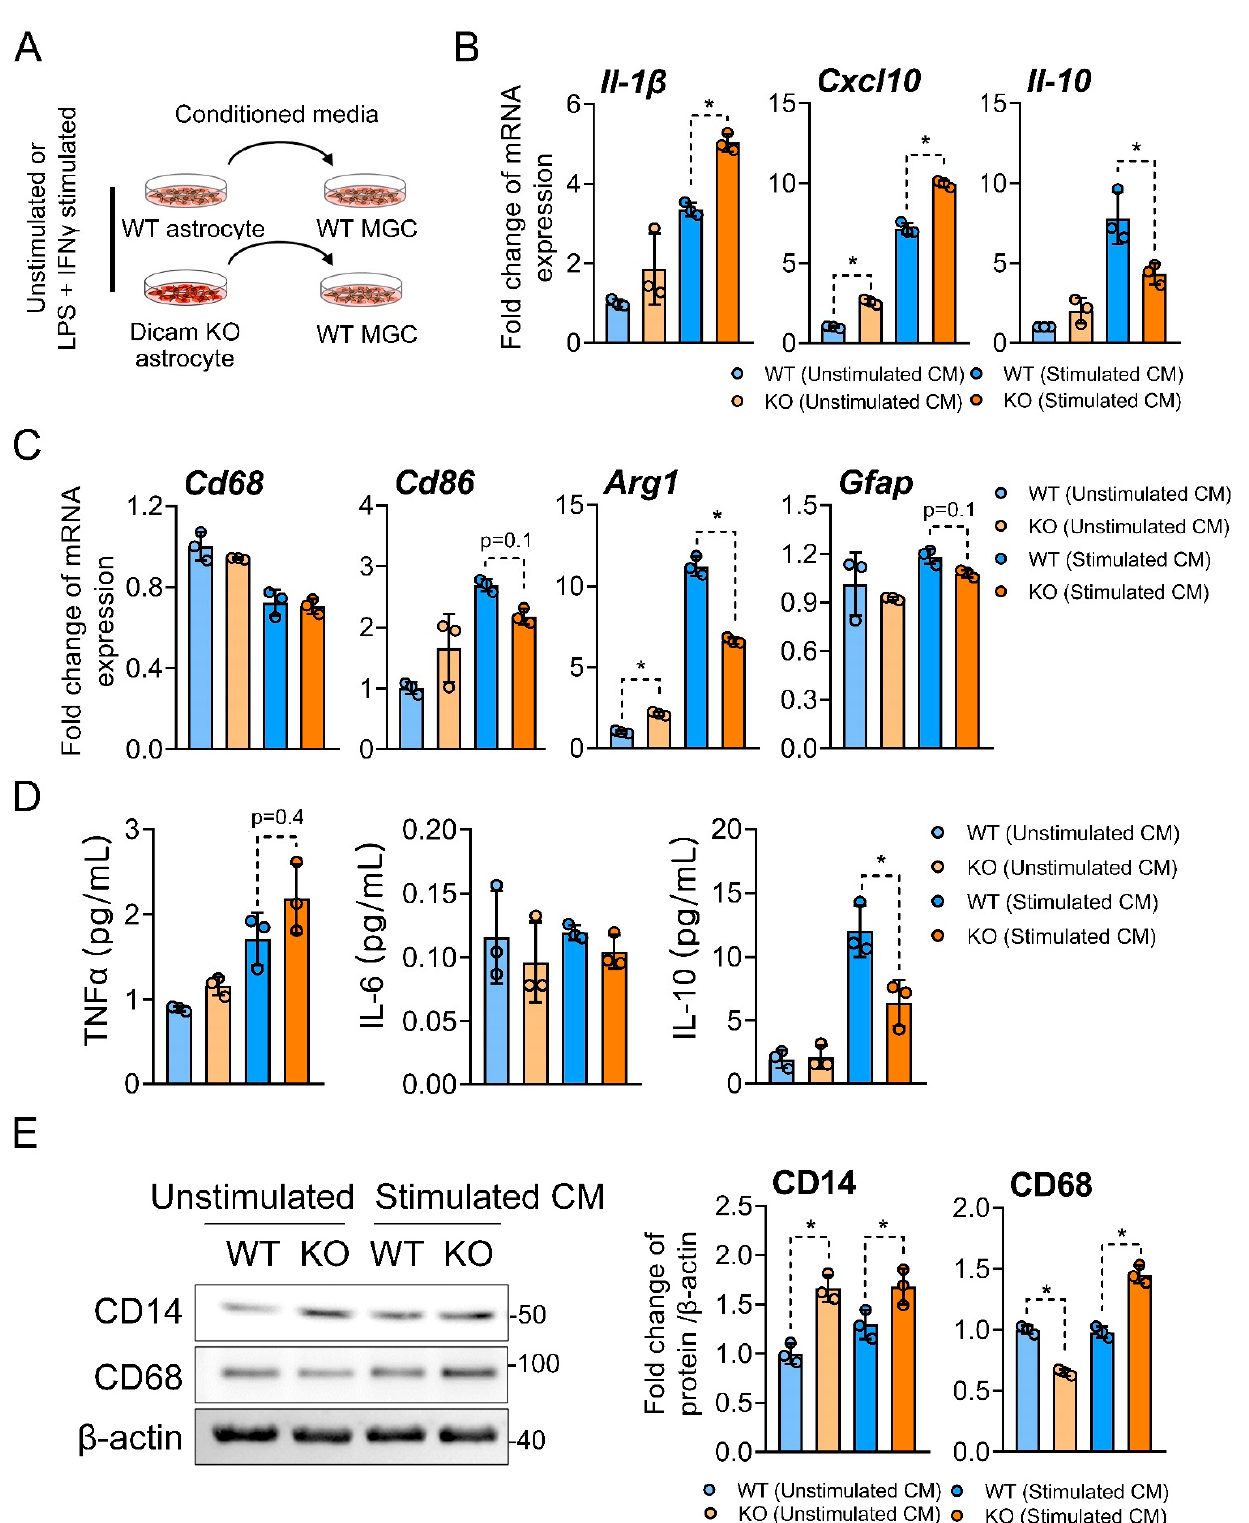
Figure 5. Conditioned media from stimulated DICAM KO astrocytes recapitulates an inflammatory phenotype in primary mixed glial cell culture. ( A ) Primary astrocytes from DICAM KO mice and their WT littermates were stimulated with 100 ng/mL of LPS and 10 ng/mL of IFN- γ for 24 h and then replaced with serum-free media. After 24 h, the conditioned media were collected and treated to the primary mixed glial cell culture from WT mice. ( B , C ) Quantitative PCR analysis